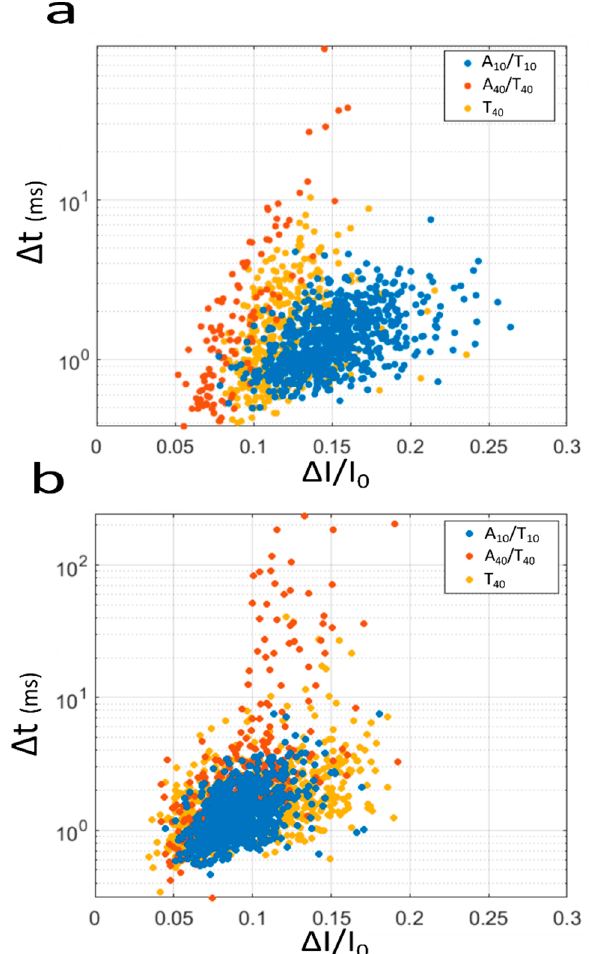
Figure 3. Scatter plot representing the Δ t versus the I/I 0 for the A 10 /T 10 (blue), A 40 /T 40 (orange), T 40 (yellow) for a voltage of ( a ) 250 mV and ( b ) 500 mV. The results were obtained using the pore d t = 3 nm, d b = 200 nm. The number of events recorded at 250 mV n = 703, 116 and 382 and at 500 mV n = 793, 332 and 640 for A 10 /T 10 , A 40 /T 40 and T 40 , respectively.